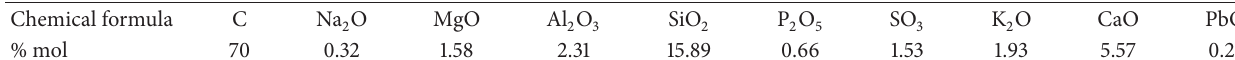
Table 2: EDS: elemental analysis of the CBC.